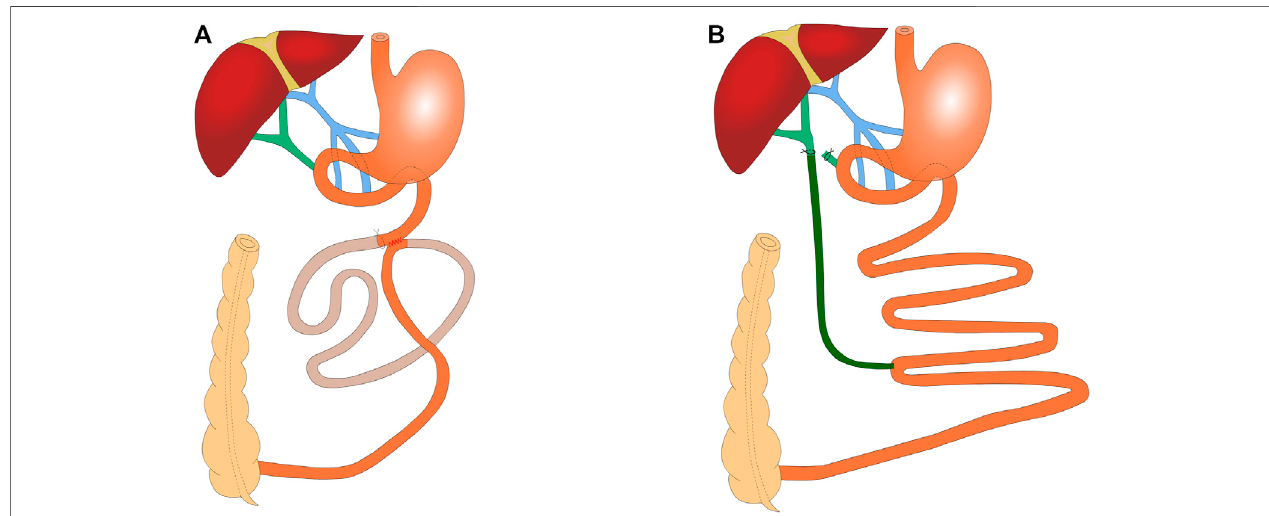
FIGURE1| SchematicofSSJIBL ( n = 6)and BID ( n =6) (A) SSJIBL procedure torestoreintestinal continuity withalateral anastomosis using thedistal6 cmofthe ligament of Treitz and the proximal 30 cm of the ileocecal valve as reference points and a ligation at the proximal end of the bypassed intestine (~1 cm from the anastomosis), with~60%oftheentiresmallintestinebeing bypassed. (B) BID procedure: thelower portion ofthecommon bileduct wasligated fi rst,and theone endof the common bile duct was placed 0.5 cm above the ligation site with a silicone hose; the other end of the silicone hose was placed in the ileum at 30 cm from the ileocecal